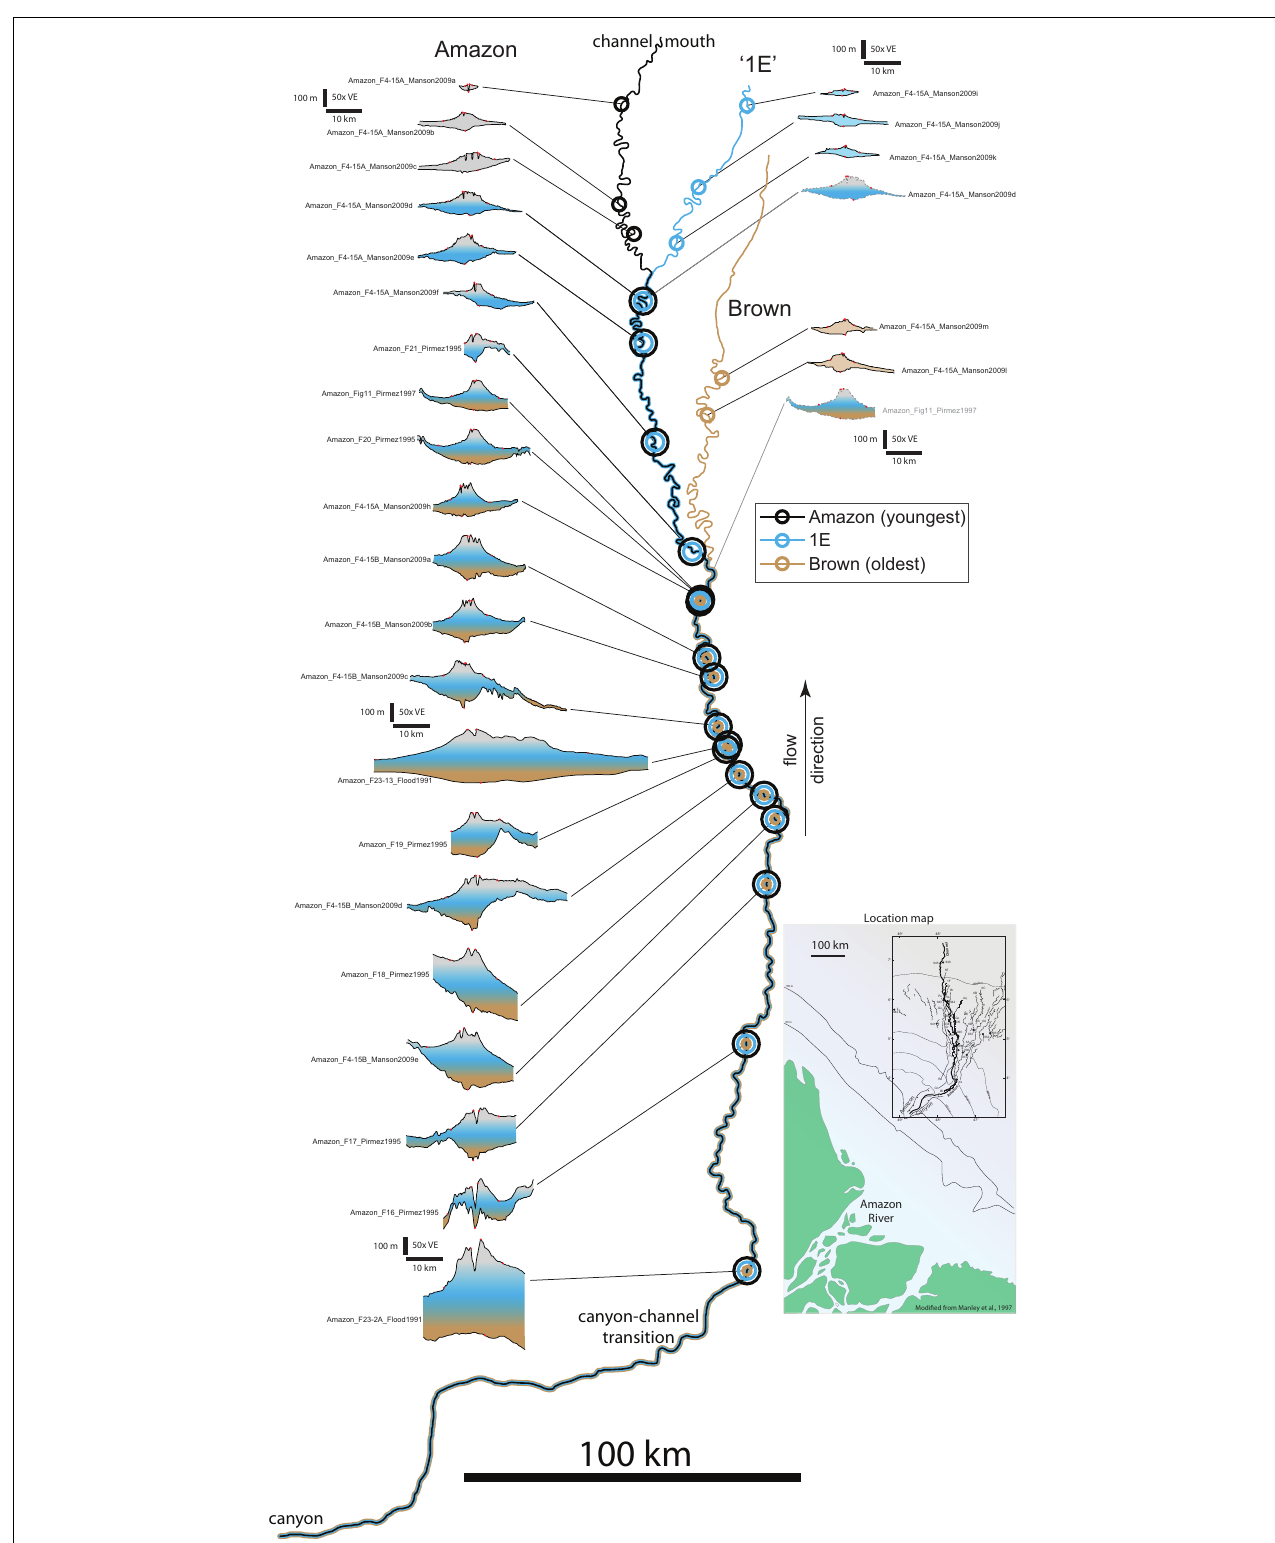
FIGURE 9 | Amazon map showing location of the Brown, 1E, and modern Amazon channel segments, as well as the location of channel cross-sections derived from seismic reflection data. Inset shows the location of the Amazon fan-channel system offshore Brazil.